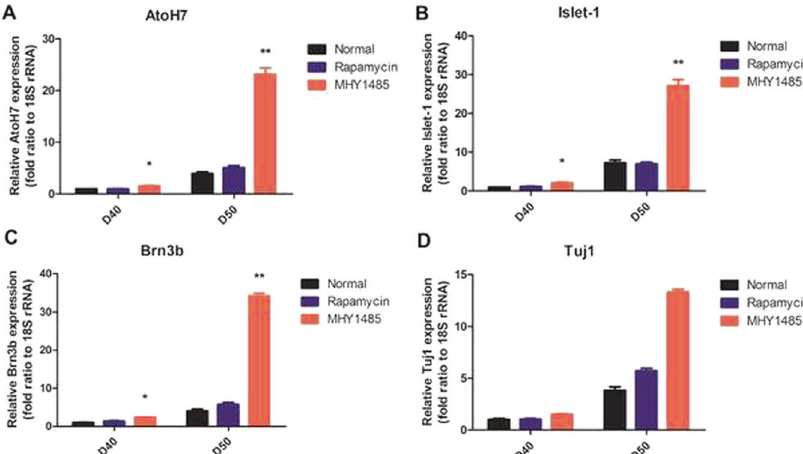
Fig. 7 Quantitative RT-PCR analysis of ROs for RGC markers upon rapamycin and MHY1485 treatment. Relative AtoH7 ( A ), Islet-1 ( B ), Brn3b ( C ), and Tuj1 ( D ) expression level in ROs treated with rapamycin or MHY1485 and untreated controls. MHY1485-treated ROs showed signi fi cantly increased expression of RGC markers Data are expressed by mean ± S.E.M. ** p < 0.01, by the Kruskal – Wallis test with post hoc